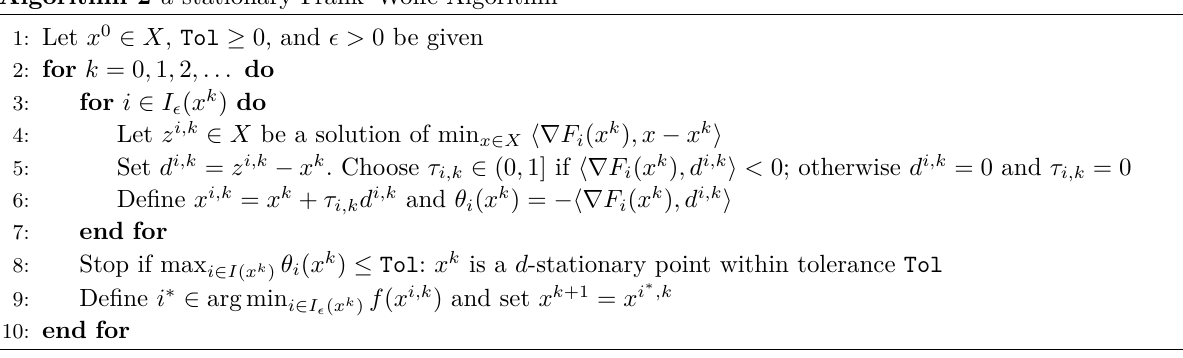
Algorithm 2 d -stationary Frank–Wolfe Algorithm